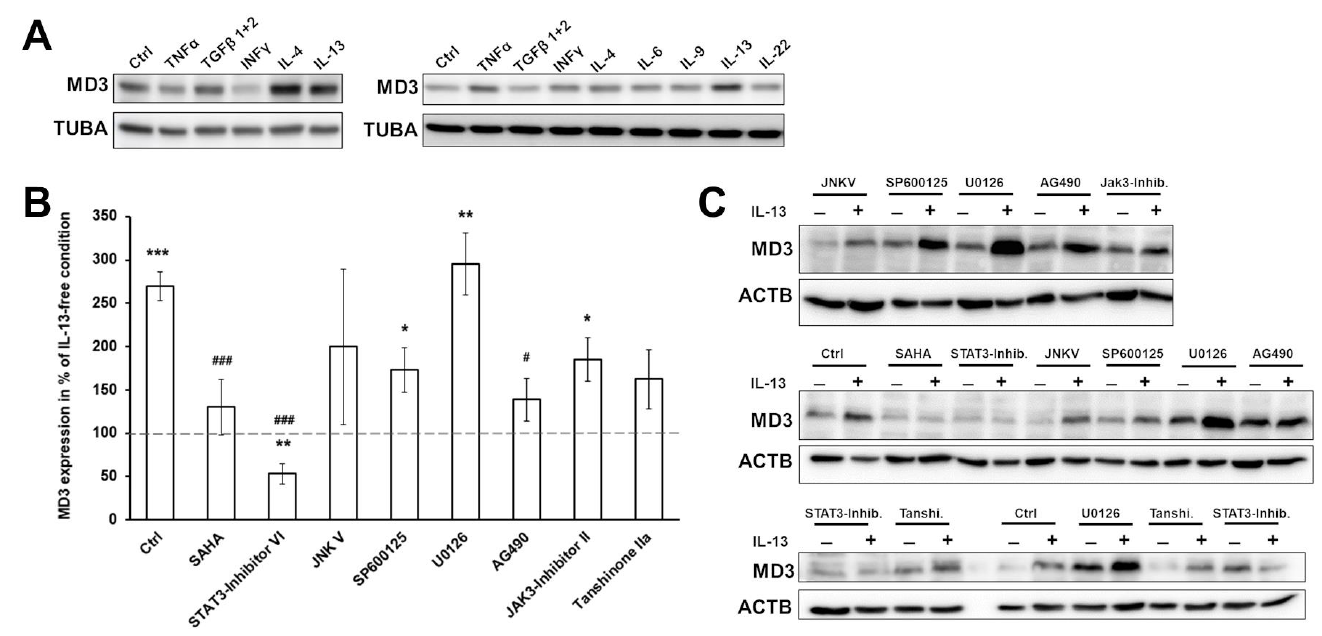
Figure 3. Analysis of signaling pathways regulating MD3 expression. ( A ) Western blot images of screening for cytokines having an upregulating effect on MD3 in HT-29/B6 cells. ( B ) Densitometric analysis of MD3 expression in HT-29/B6 under the influence of IL-13 and different inhibitors. Among the tested inhibitors, STAT3 and STAT6 inhibition led to loss of the effect of IL-13 on MD3 expression (control = condition without any inhibitor pretreatment, * p < 0.05; ** p < 0.01; *** p < 0.0001 tested against the respective IL-13-free condition; # p < 0.05; ### p < 0.001 tested against IL-13 treatment; n = 3–5). ( C ) Representative Western blot images.